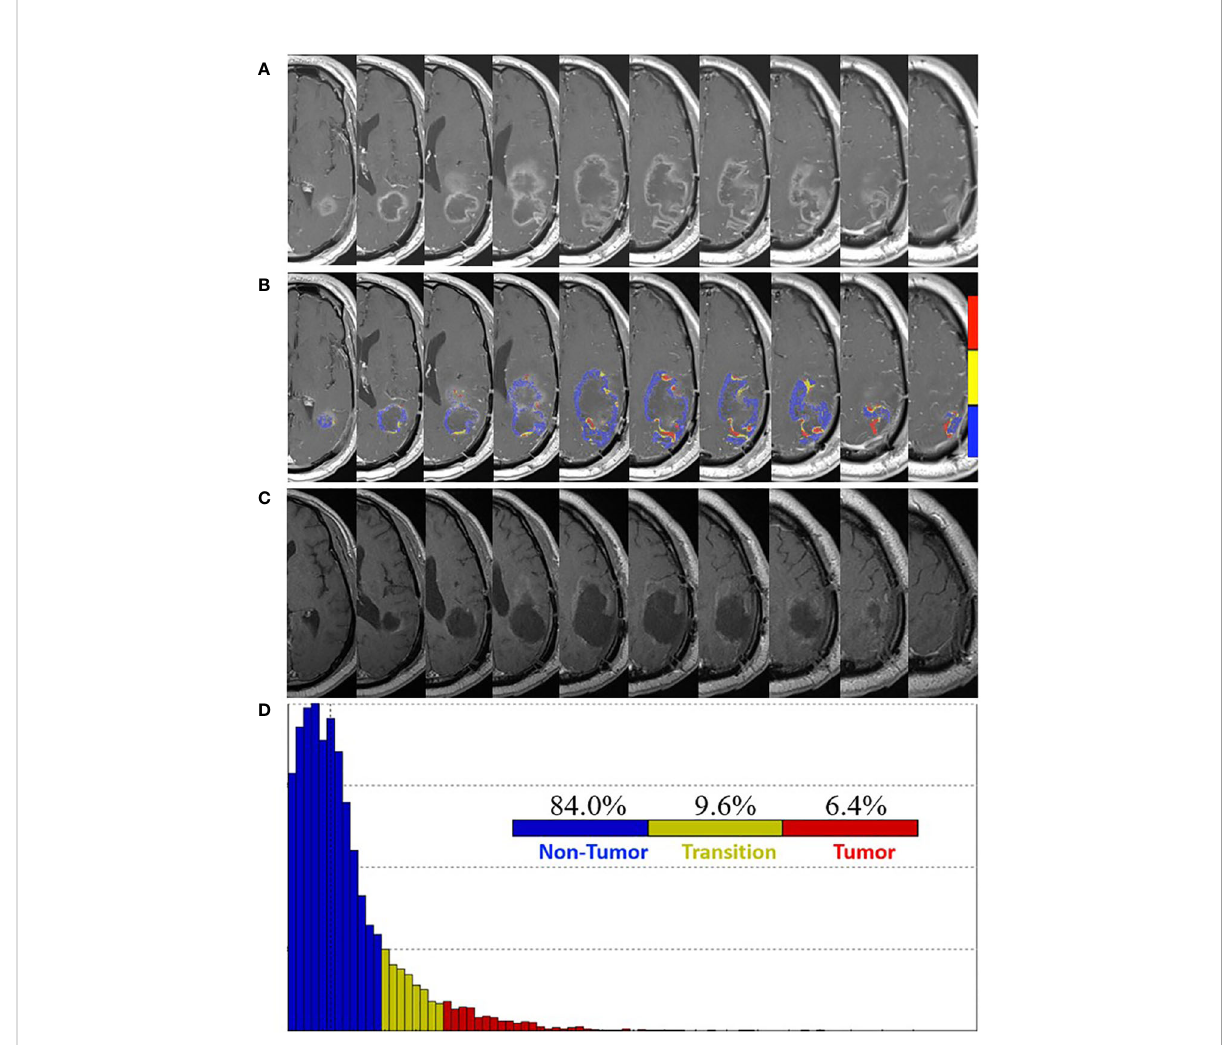
FIGURE 2 Pre- and post-surgery MRI. (A) Postcontrast T1-weighted MRI obtained fi ve weeks post-pLDR and two weeks before redo-surgery. (B) Corresponding maps of FTB superimposed on the postcontrast T1-weighted MRI images. The FTB maps show areas of active tumor (red), treatment effect (blue), and transitional zone (yellow). (C) Post-surgery (four weeks) postcontrast T1-weighted MRI demonstrating extent of resection. (D) Distribution of T1- weighted enhancement volume based on vascularization as measured by FTB